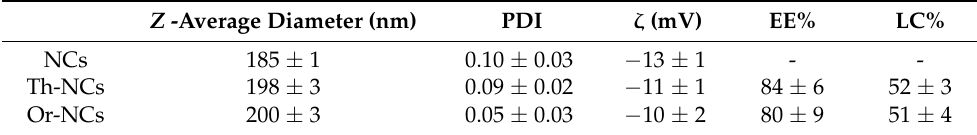
Table 5. Physicochemical characterization of EO-NCs and NCs (empty).